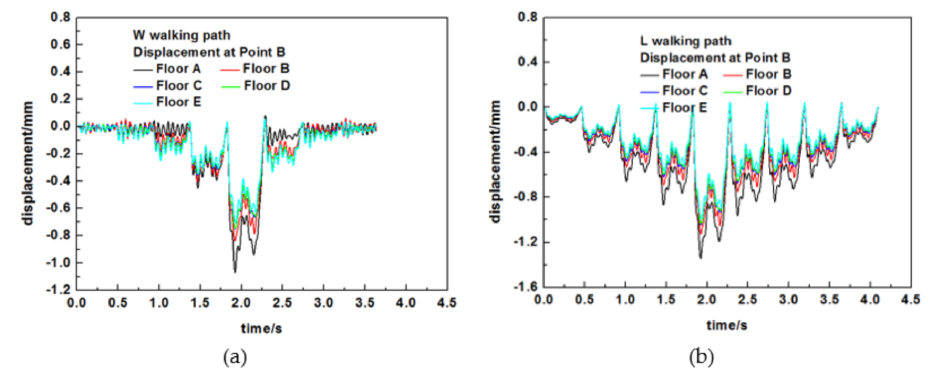
Figure 26. Displacement responses at points B for tested floors: ( a ) W walking path and ( b ) L walking path.